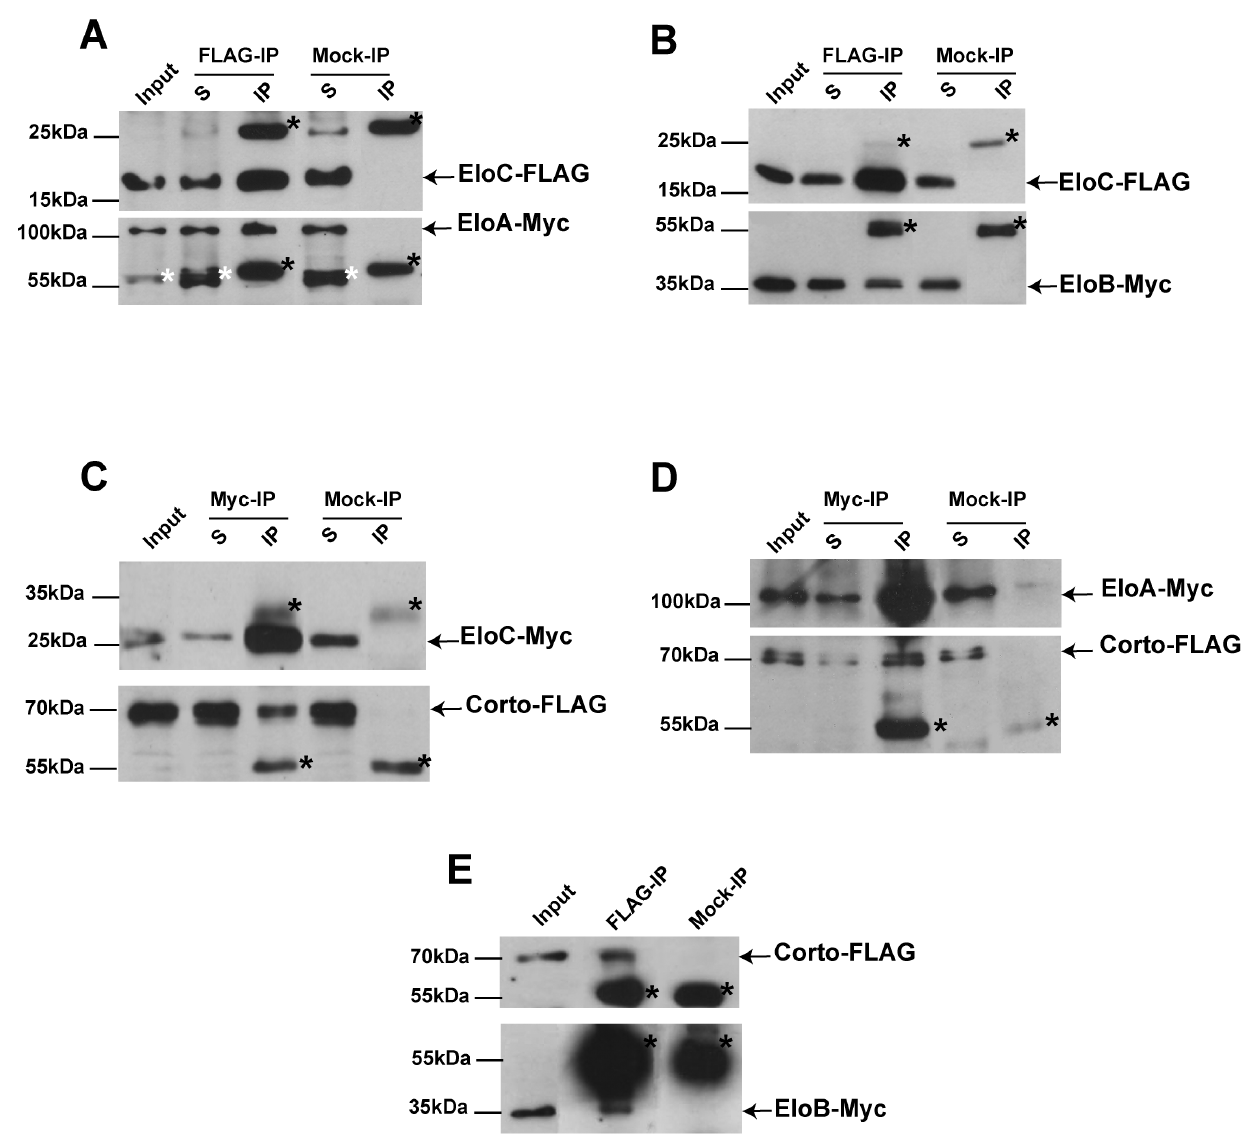
Figure 1. Corto interacts with the Elongin complex invivo. (A, B): EloA-Myc (A) and EloB-Myc (B) co-immunoprecipitate with EloC-FLAG; (C, D): Corto-FLAG co-immunoprecipitates with EloC-Myc (C) and EloA-Myc (D); (E): EloB-Myc co-immunoprecipitates with Corto-FLAG. In D and E, co- immunoprecipitations were performed after cross-linking. In E, exposure time for the lower panel was 50 times longer than for the upper panel. Immunoprecipitations were performed with anti-Myc (Myc-IP), anti-FLAG (FLAG-IP) or anti-HA (Mock-IP) antibodies. Immunoprecipitated proteins were revealed by Western blot using anti-FLAG or anti-Myc antibodies. Arrows show immunoprecipitated proteins, and black asterisks point to heavy or light IgG chains. In A, white asterisks indicate a non-specific band. S: supernatant after immunoprecipitation; IP: protein G-agarose beads. 5% of the input or supernatant and 50% of the immunoprecipitate were loaded onto the gels.